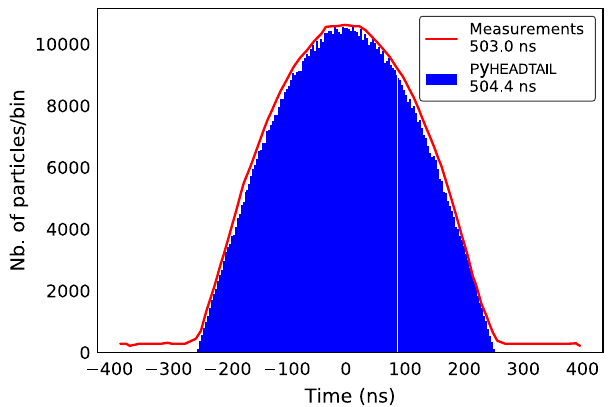
FIG. 8. Longitudinal distribution as measured with tomography [29] (red) and P y HEADTAIL simulation using a matched parabolic distribution (blue).